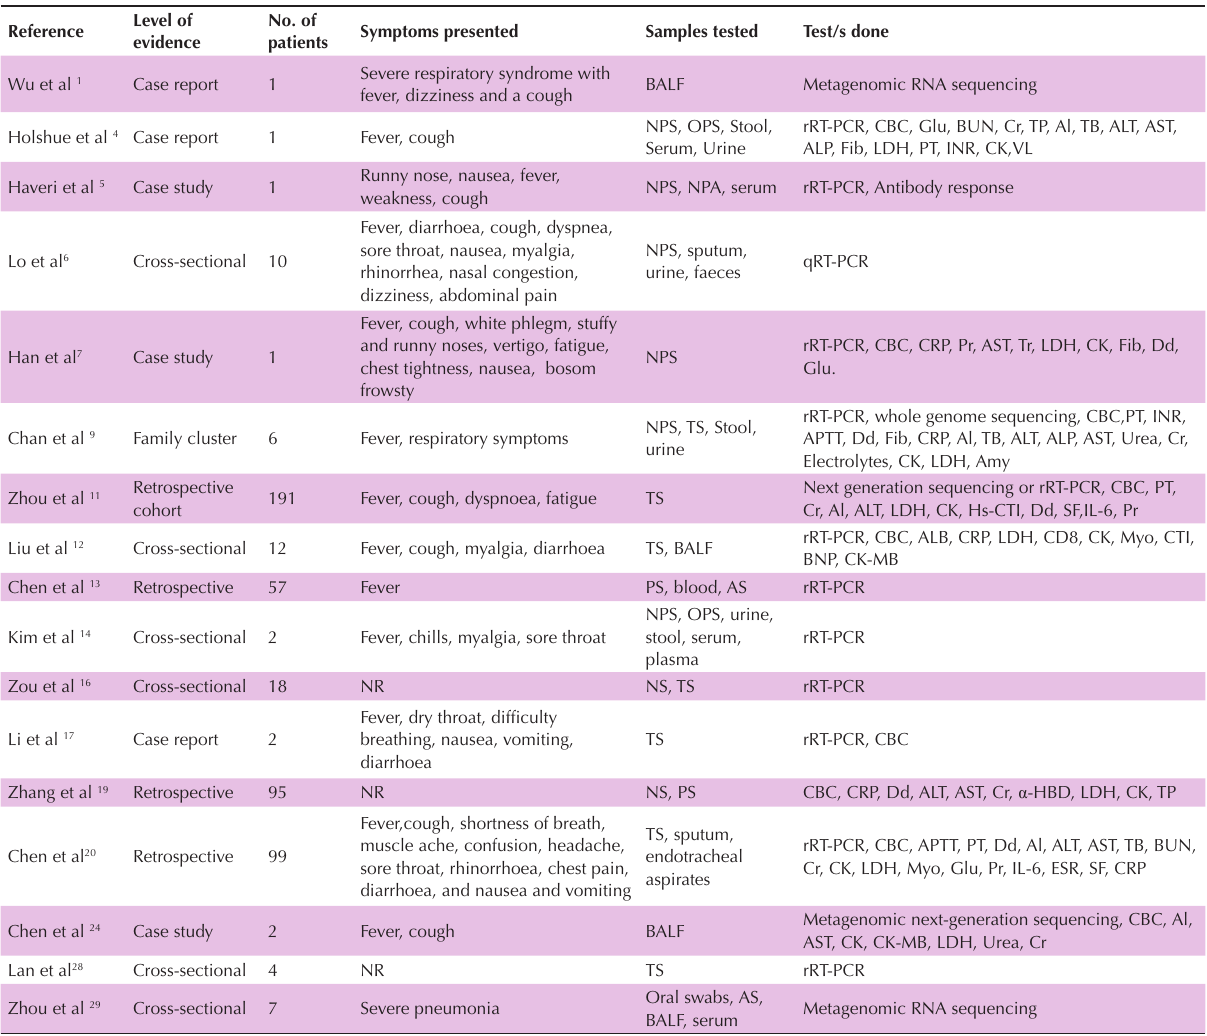
Table 1. Summary of the clinical studies included in the review